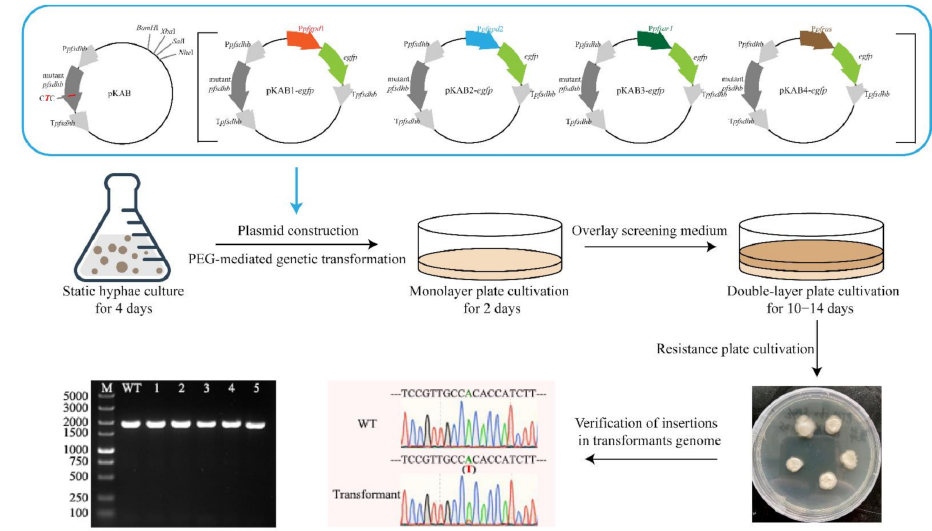
Figure 1. The basic steps of the PEG-mediated protoplast transformation and transformant verifica- tion in P. eryngii var. ferulae . The process includes static hyphae culture, monolayer plate cultivation, double-layer plate cultivation, re-screening, and transformant verification. The pfsdhb gene is ampli- fied using the wild-type and transformant genomes as templates. Lane WT, wild-type strain; Lanes 1–5, the strain transformed with pKAB. PCR products amplified from the transformant or wild-type strains were sequenced. The position of the bracket indicates the mutated